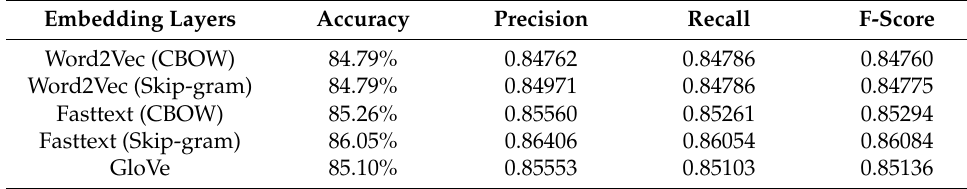
Table 10. The Median Values Obtained using Three Dense